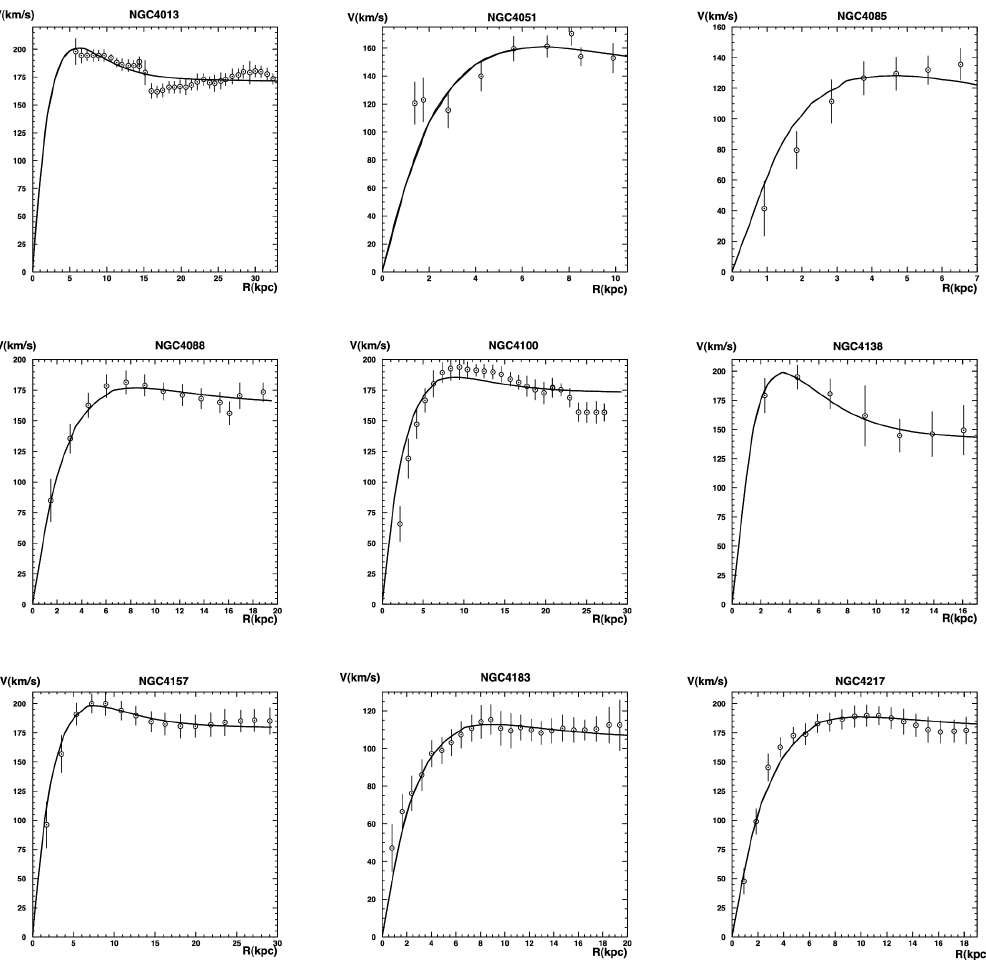
Figure 25. Galaxy rotation curves from the THINGS catalogue fitted with MOG. The best fits are shown as black lines. The figure is reproduced from